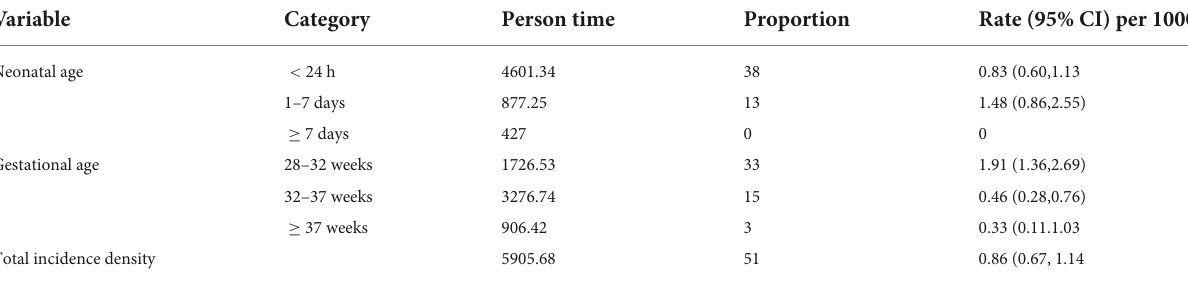
TABLE 3 Overall incidence rate and incidence rate for neonatal age and gestational among LBW neonates admitted to the NICU of FHCSH, Ethiopia from 1 January 2015 to 30 December 2019.